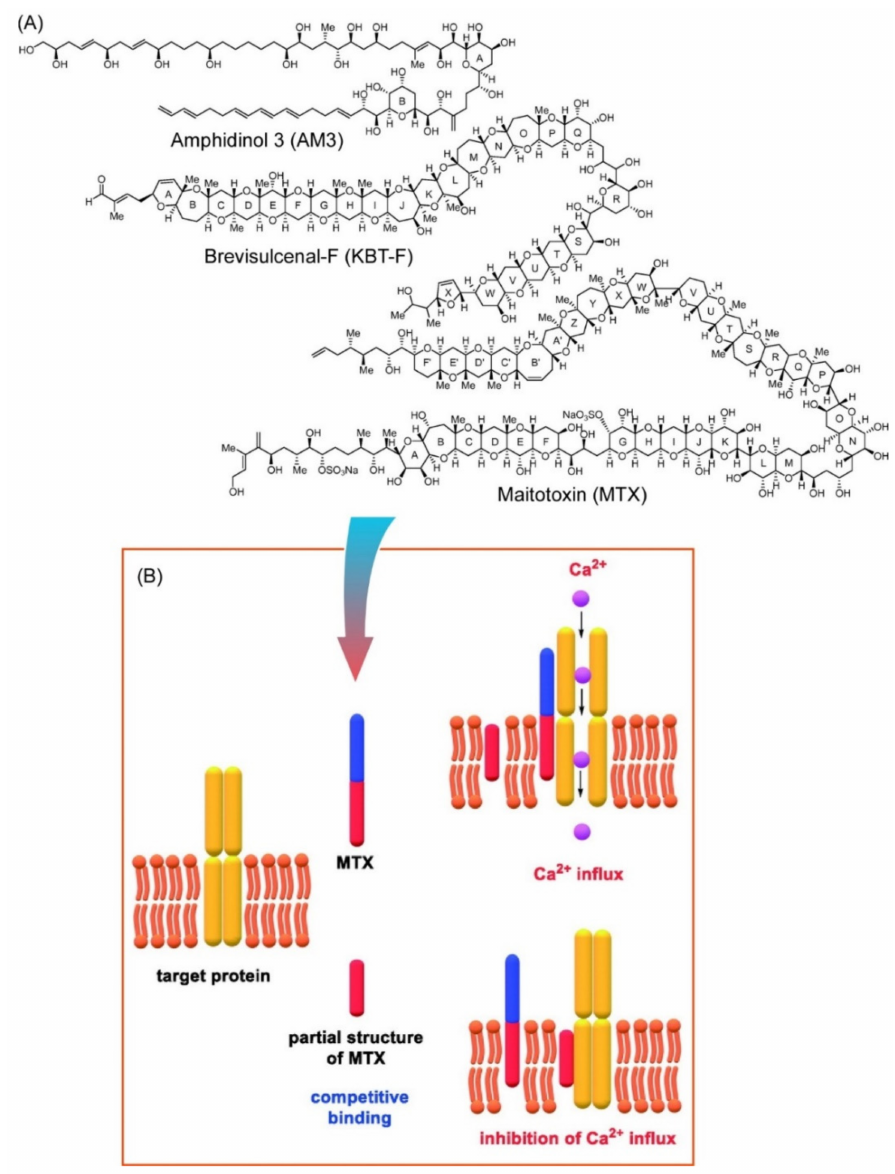
Figure 3. ( A ) Structures of so-called super carbon chain natural products, amphidinol 3 (AM3), brevisulcenal-F (KBT-F), and maitotoxin (MTX). ( B ) Possible inhibition mechanism on Ca 2+ influx through a cell membrane induced by MTX. Reprinted with permission from Reference [100]. Copy- right 2020 Chemical Society of